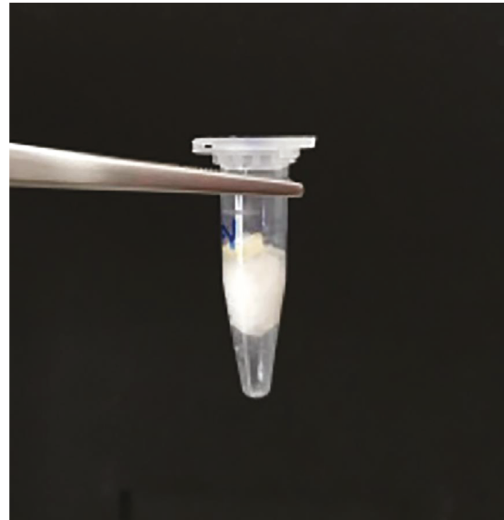
Figure 3: A specimen wrapped in gauze.